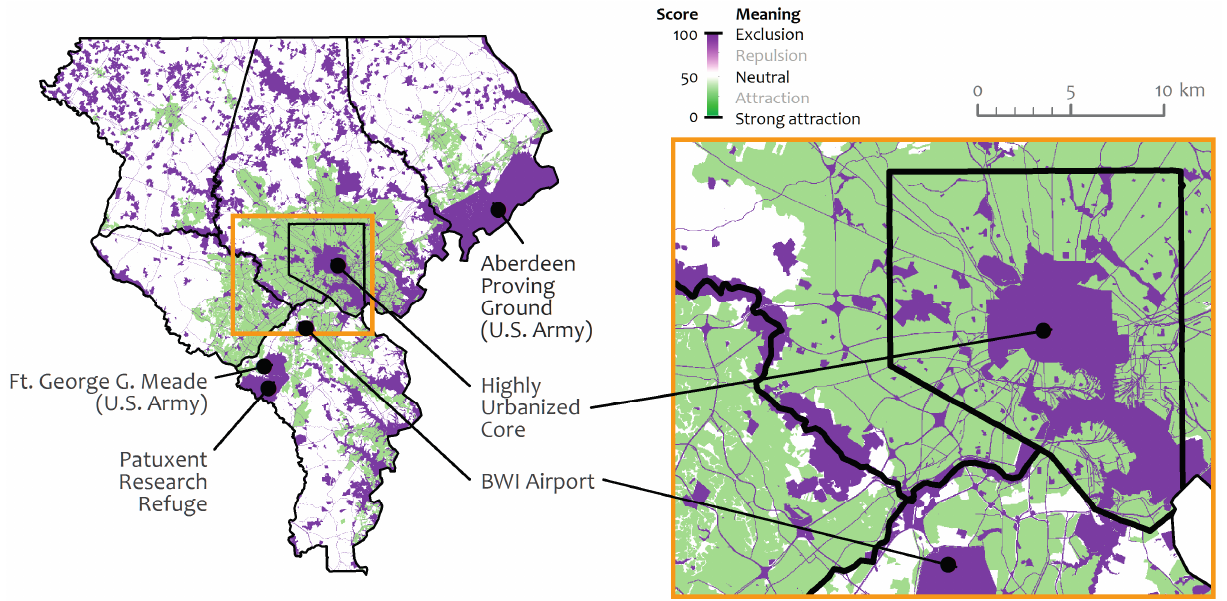
Figure 4. The Exclusion/Attraction layer used to calibrate the “infrastructure” instance of the BMR SLEUTH model. Locations in sewer and water service areas were assigned a mild attraction score